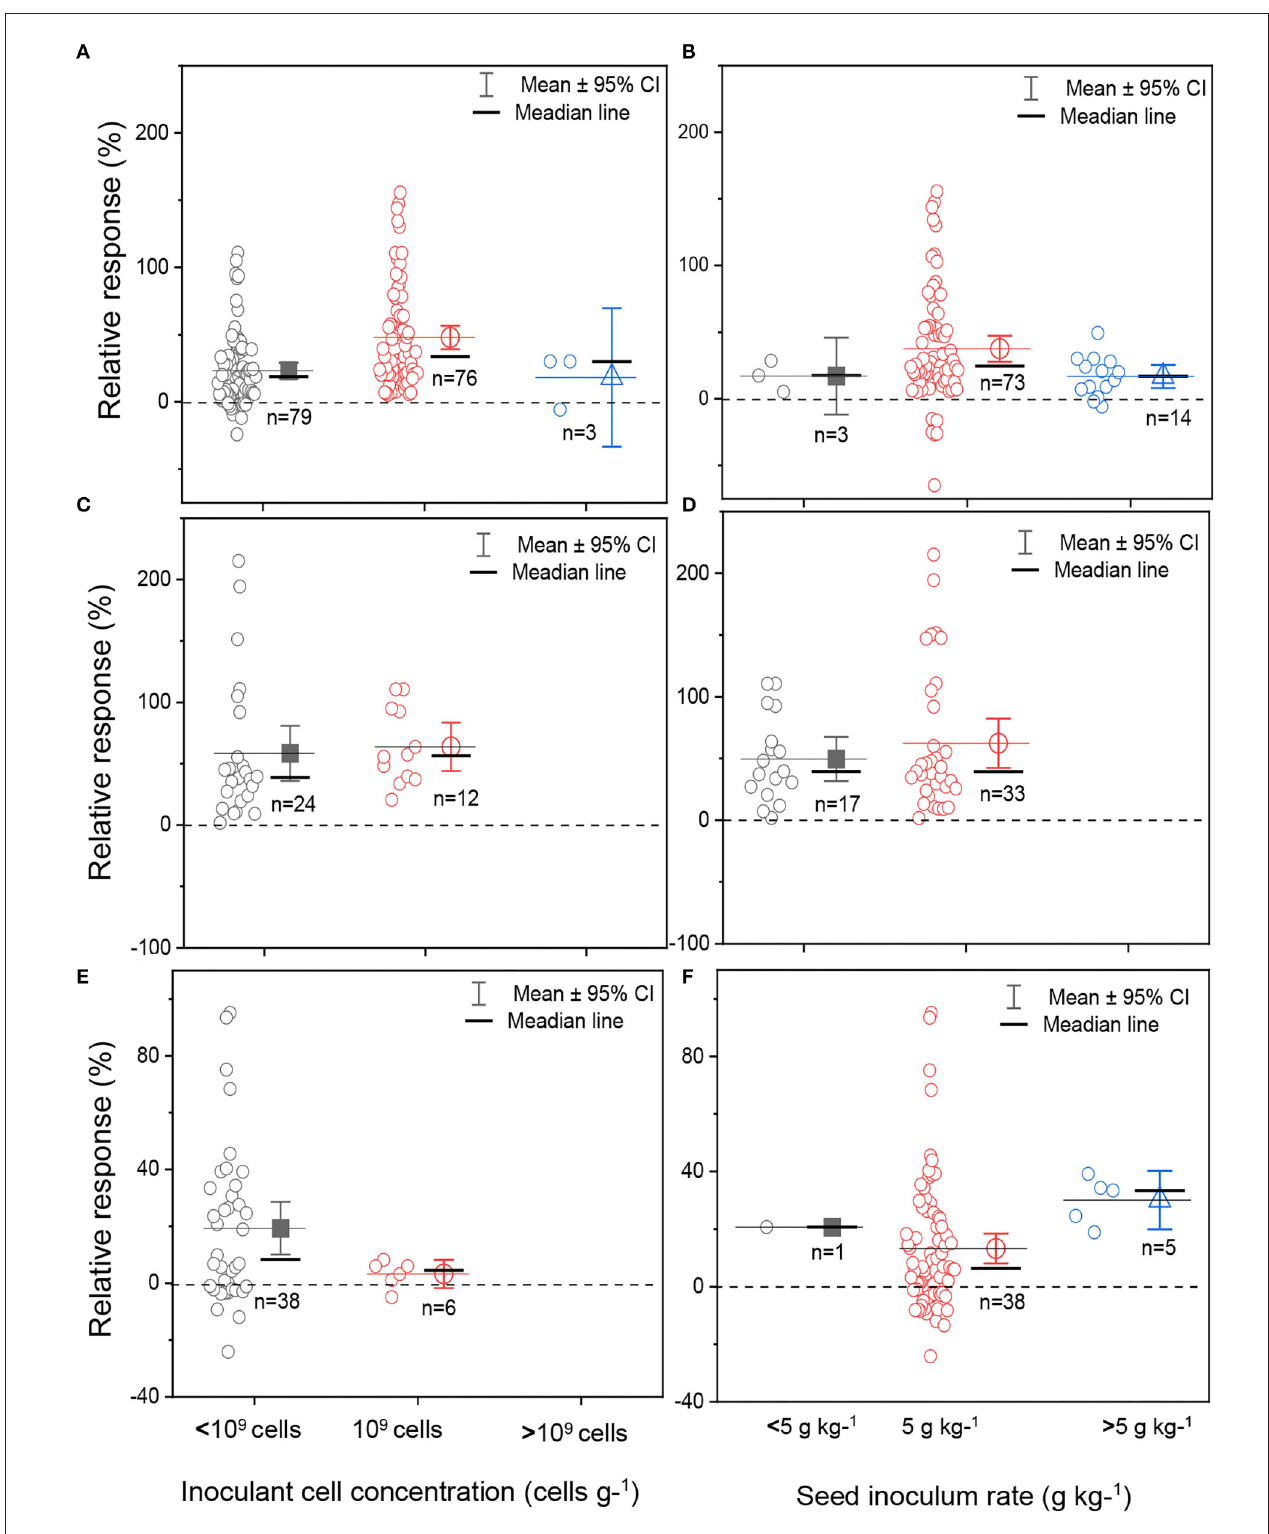
FIGURE 6 | Boxplot and scatter data (open circle symbol) of soybean (A,B) , cowpea (C,D) , and groundnut (E,F) grain yield responses to bacterial cell inoculant concentration (A,C,E) and inoculant seed coating density (B,D,F) under Ghana soil conditions. The mean values (different symbols) with 95% bootstrap confidence interval (CI), the median line, and the sample size are